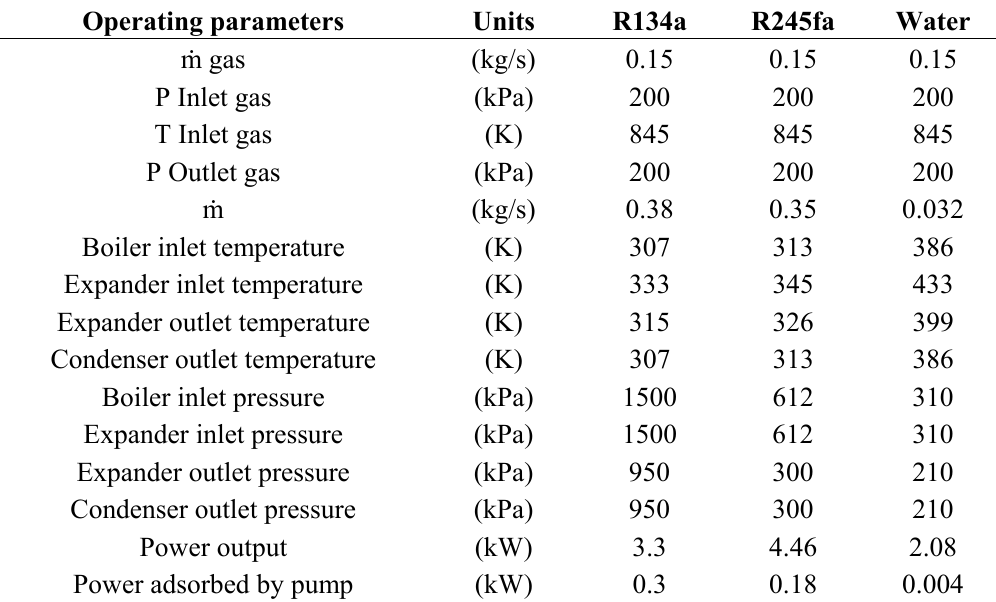
Table 2. ORC with different working